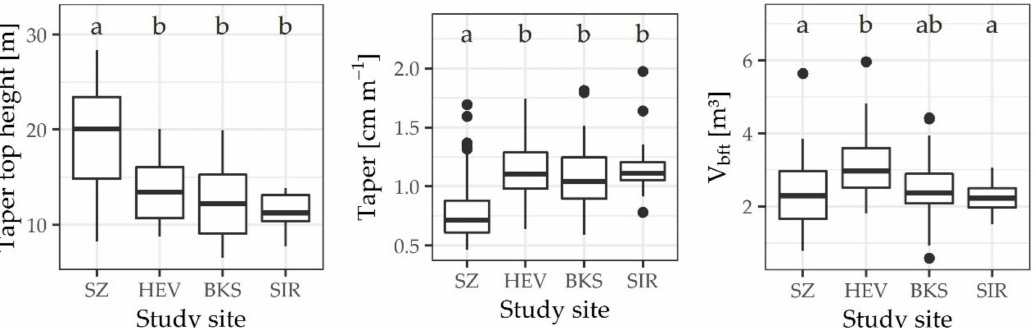
Figure 5. Variation in taper top height, taper and the wood volume of the branch-free trunk between the stands along the management gradient. Different letters indicate significant differences (Tukey-HSD, p < 0.03) between study sites. V bft = Volume of branch-free trunk. SZ = Schattiner Zuschlag (long-term unmanaged), HEV = Hevenbruch (short-term unmanaged), BKS = Berkenstrücken (extensively managed), SIR = Sirksfelder Zuschlag (intensively